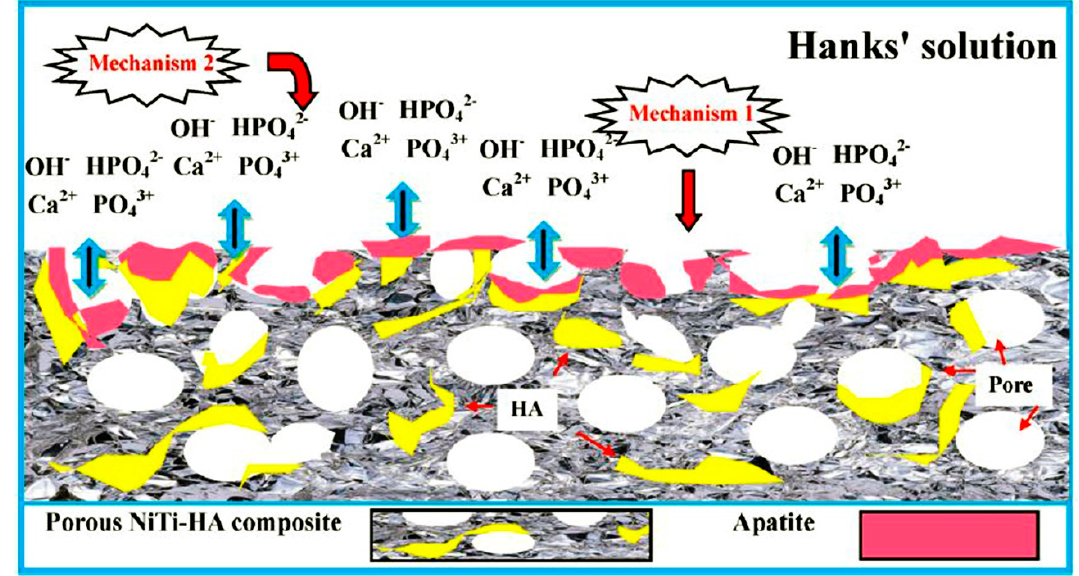
Figure 13. Schematic illustration of the formation mechanism of bone-like apatite layer on the surface of porous NiTi-HA composites [6].